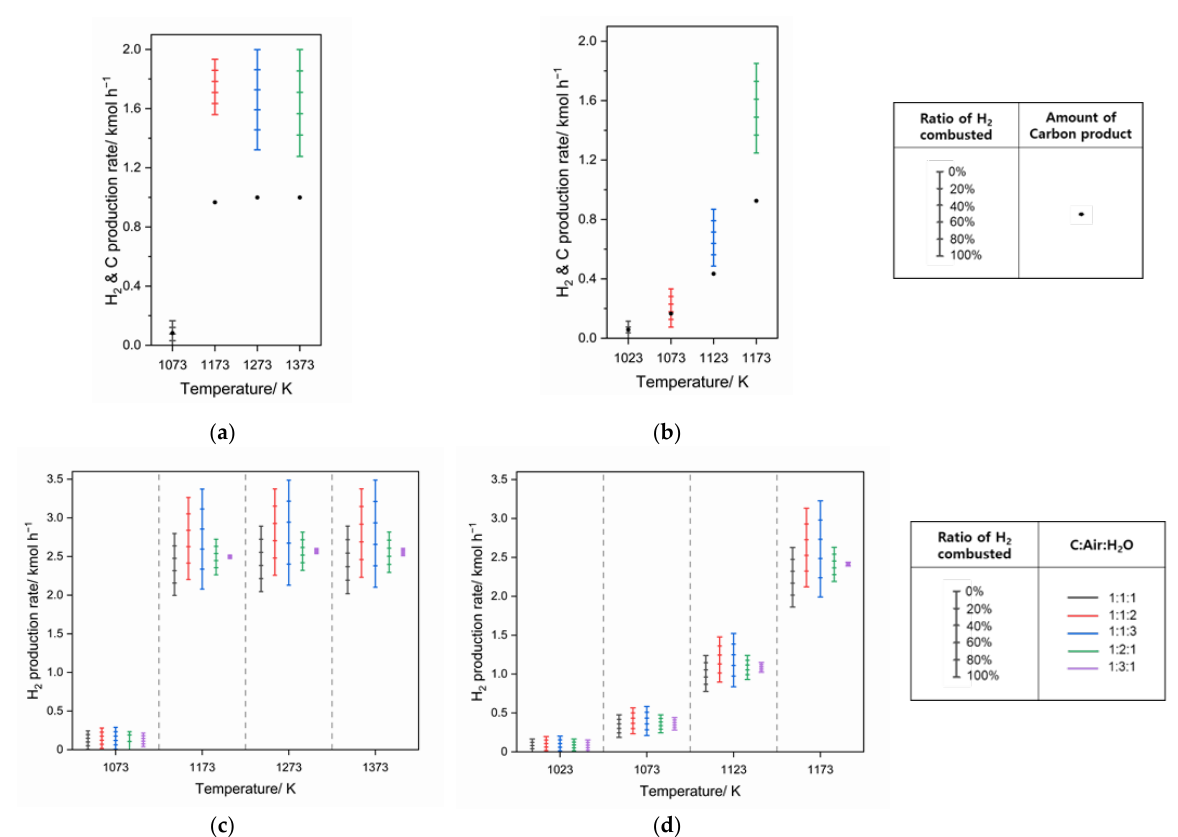
Figure 4. Technical performance for methane pyrolysis (MP) systems of ( a ) thermal methane pyrolysis (TMP-S1), ( b ) catalytic methane pyrolysis (CMP-S2), and systems with additional gasification and WGS reaction of ( c ) TMPG-S3 and ( d ) CMPG-S4.